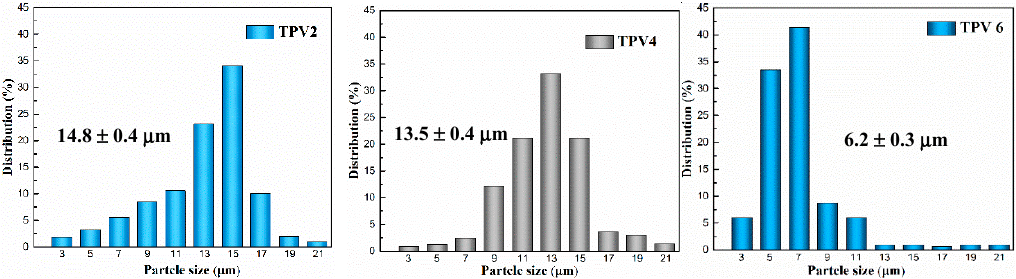
Figure 5. Particle size distribution of TPV2, TPV4 and TPV6 samples.